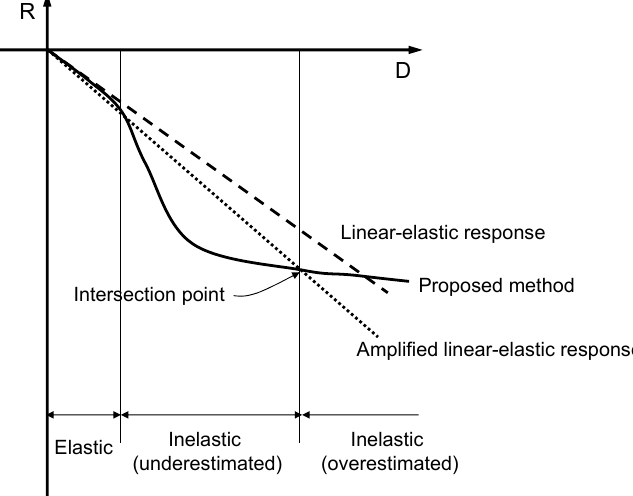
Figure 8. Comparison between inelastic torsional responses using the current design code and proposed approach.